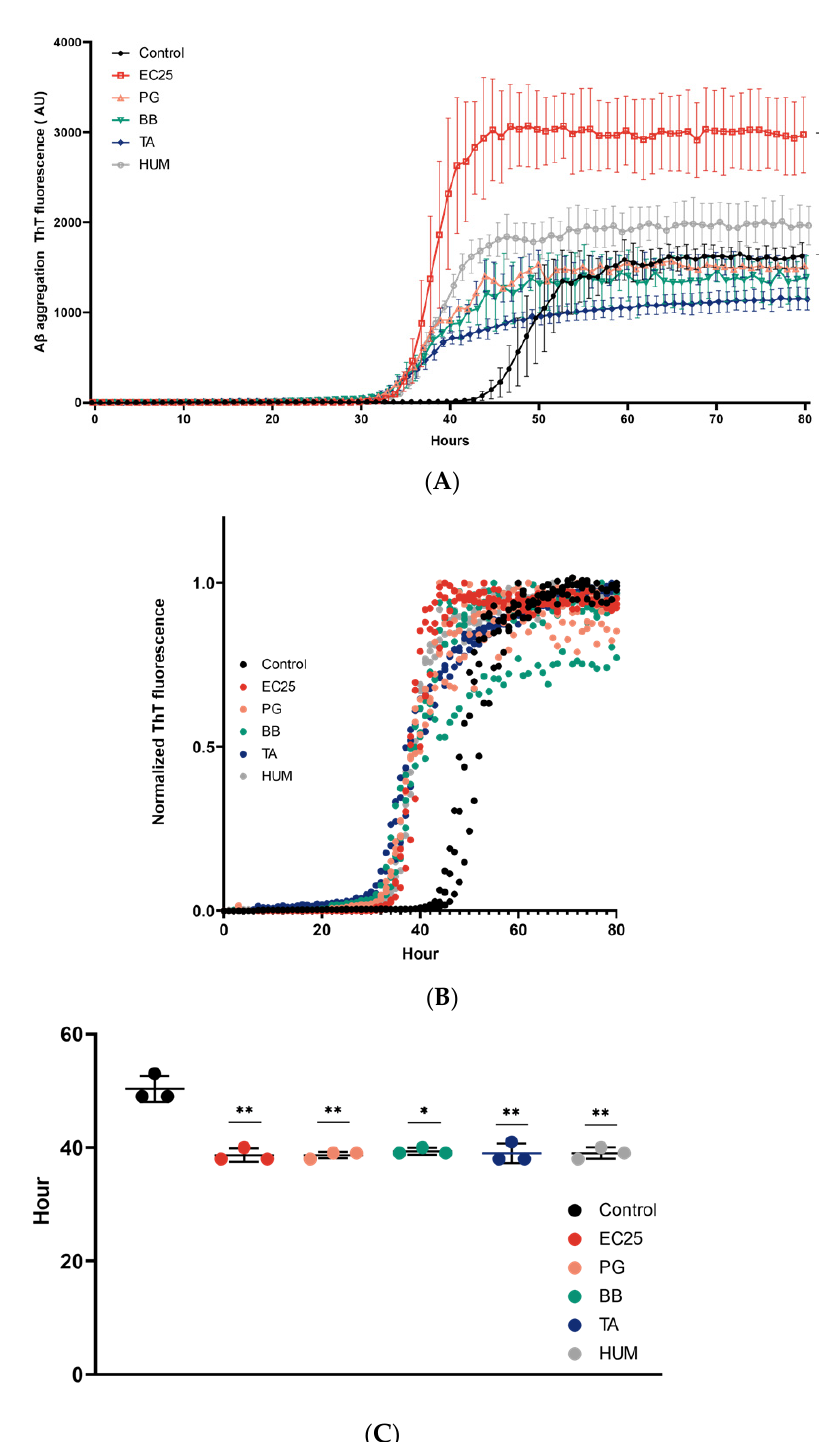
Figure 1. Effects of bacterial and human DNA on amyloid β (A β ) aggregation. ThT fluorescence assay was used to monitor the aggregation of A β (1-42) at 6 µ M in 50 mM tris-HCl in the presence and absence of bacterial DNA of E. coli ATCC25922 (EC25), P. gingivalis (PG), Borrelia burgdorferi (BB), T. alzheimeri (TA), or human DNA (HUM) at 1000 ng/mL. ( A ) ThT fluorescence as a function of time (h), ( B ) normalized ThT fluorescence as a function of time, ( C ) and the corresponding t1/2 values. Each experiment was performed in triplicate. For images ( A ) and ( C ), data are presented as mean ± SD * p ≤ 0.05 ** p ≤ 0.01; for ( B ), the individual traces from three replicates are shown.